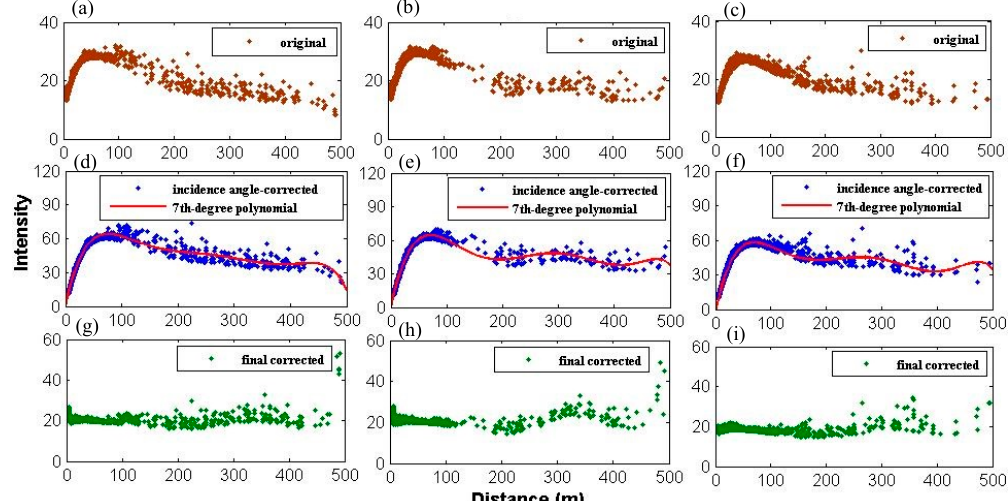
Figure 5. ( a – c ): Original intensity data. ( d – f ): Incidence angle-corrected intensity data and 7th-degree fitting polynomials. ( g – i ): Final corrected intensity data by the improved method. ( a , d , g ): Cement road from Sites 1. ( b , e , h ): Cement road from Sites 2. ( c ), ( f ), and ( i ): Cement road from Sites 3. θ s and d s are defined as 75 ◦ and 10 m, correspondingly. The vertical and horizontal axes for all the figures are intensity and distance, respectively. The number of points is 103,970, 116,242, and 135,561 for Sites 1, 2, and 3, respectively.